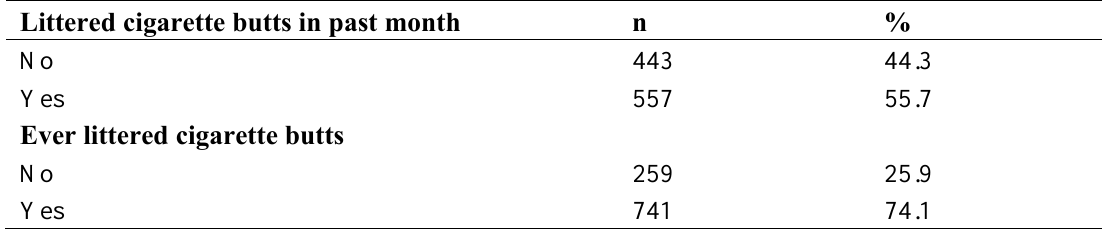
Table 3. Past-month † and ever littering * of cigarette butts (n = 1,000, smokers only). Littered cigarette butts in past month